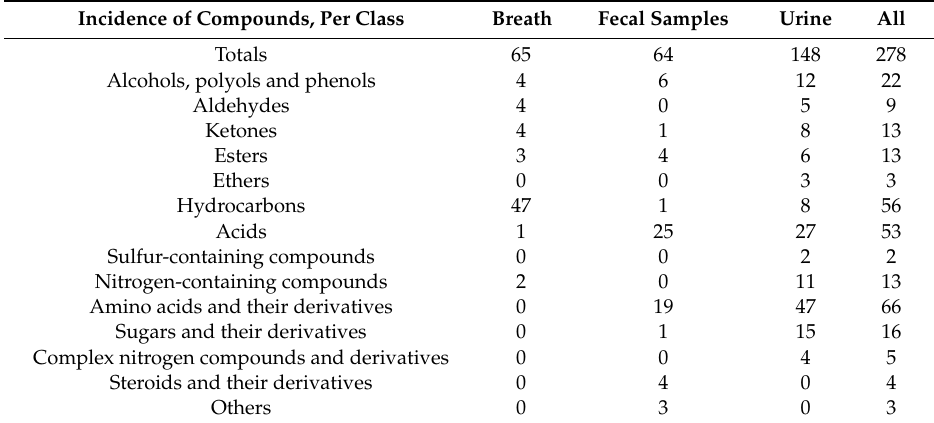
Figure 1. Incidence distribution of potential CRC biomarkers, according to functional group. Table 3. Incidence distribution of potential CRC biomarkers in all three matrices, according to functional